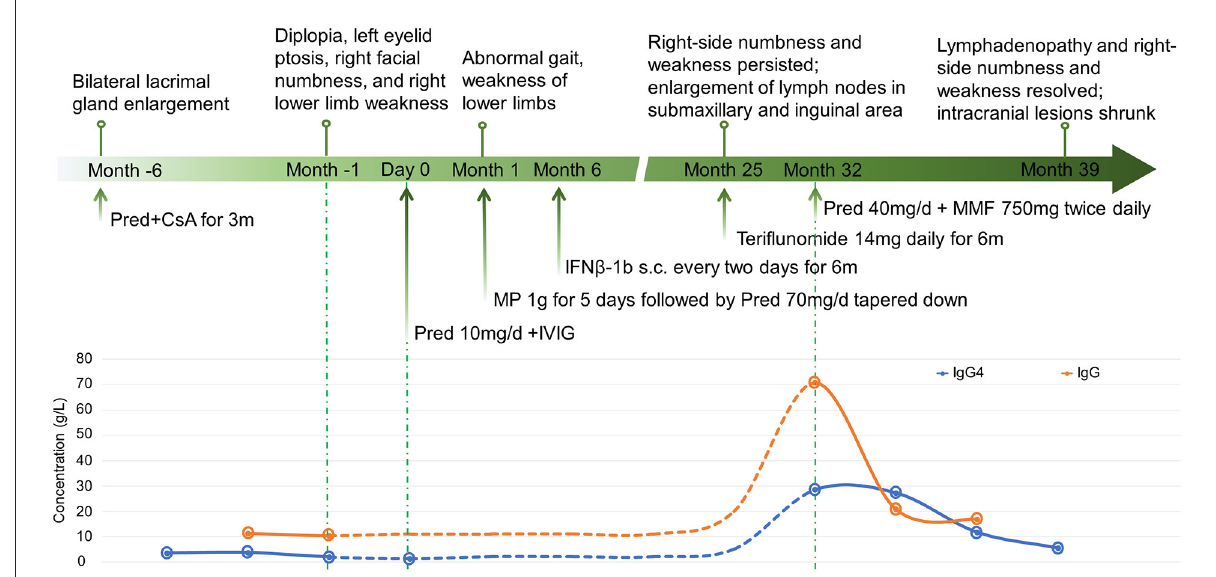
FIGURE3 The disease course, treatments, and the changes of serum IgG and IgG4 of the patient.